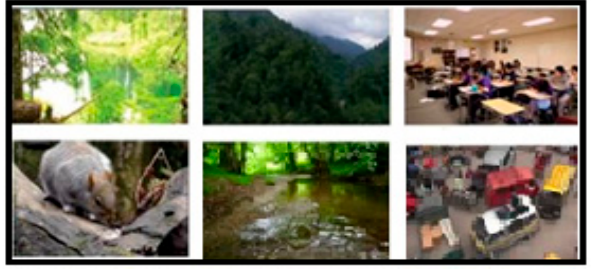
Figure 3. The environments and samples of smoke video database: examples of frames without smoke.